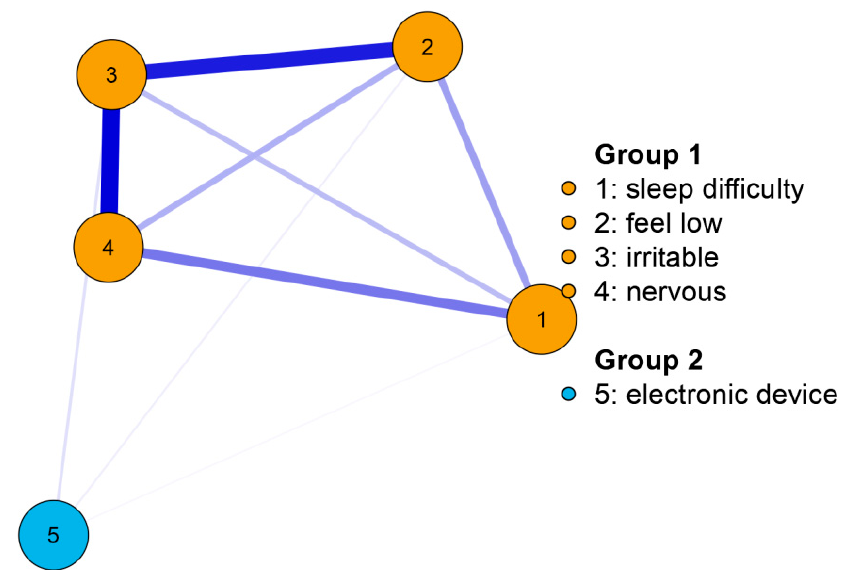
Figure 1. The network graph demonstrating the correlation between each psychological symptom and adolescents’ excessive electronic device use based on the 2006-year sample.